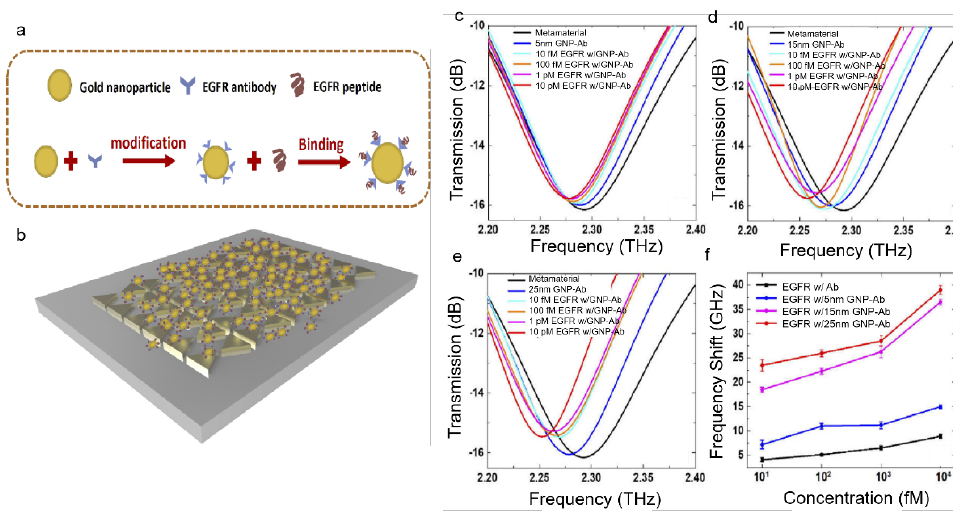
Figure 4. ( a ) Chemical binding of the antibody (Ab) molecules on the metamaterial surface. ( b ) The physical structure of the sensor with AuNPs introduced on the bow-tie structure. ( c ) The transmission spectra of a 5 nm AuNP-Ab functionalised sensor in response to EGFR. ( d ) The transmission spectra of a 15 nm AuNP-Ab functionalised sensor in response to EGFR. ( e ) The transmission spectra of a 25 nm AuNP-Ab functionalised sensor in response to EGFR. ( f ) Shifts in the resonance frequency for Ab functionalised bare metal structure (black line), 5 nm AuNP-Ab (blue line), 15 nm AuNP-Ab (purple line) and 25 nm AuNP-Ab (red line) functionalised metal structures [65] © 2021 Optical Society of America.